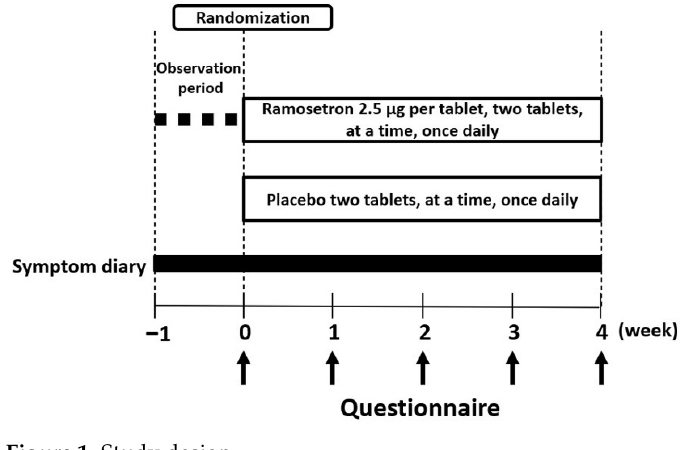
Figure 1. Study design.